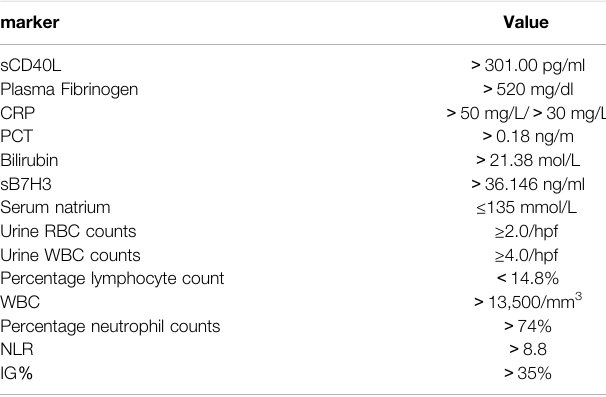
TABLE 1 | Related markers in the diagnosis of complex appendicitis in children and corresponding values.